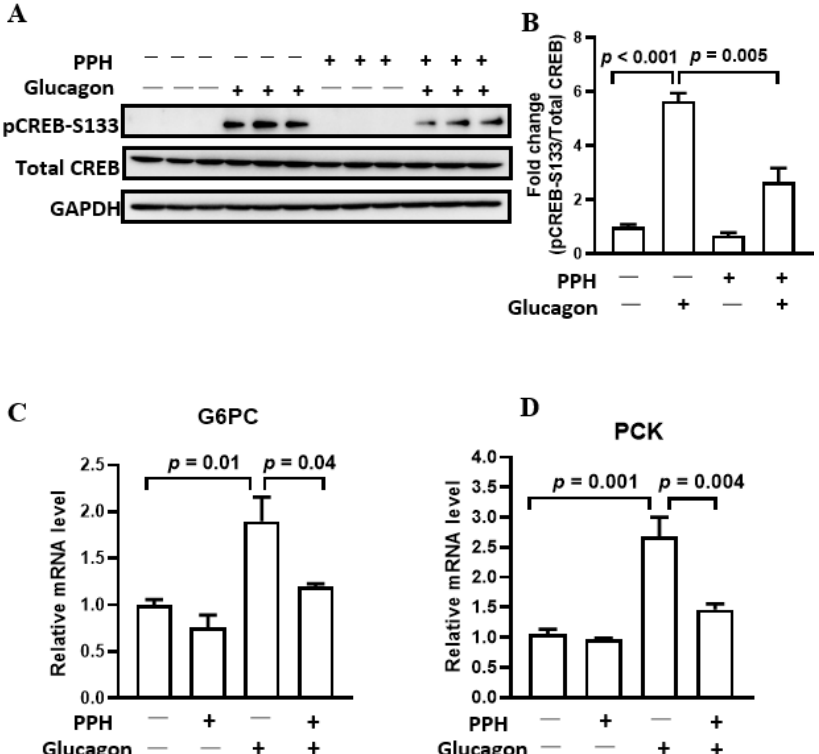
Figure 4. PPH regulated glucagon signaling in the AML-12 cells. ( A ) AML-12 cells were pre-treated with PPH for 1h, followed by the co-treatment with 100 nM of glucagon for 1h. The total protein of the cells was extracted and immune-blotted with the antibodies against pCREB-S133, total CREB, or GAPDH. ( B ) The protein band of pCREB-S133 was quantified and normalized to the total CREB. ( C , D ) AML-12 cells were pre-treated with PPH for 1h, followed by the co-treatment with 100 nM of glucagon for 6 h. Total RNA of the cells were extracted. The mRNA level of G6PC and PCK were assessed using RT-PCR, and GAPDH was used as the internal control. Data are expressed as mean ± SEM of at least 3 independent experiments.